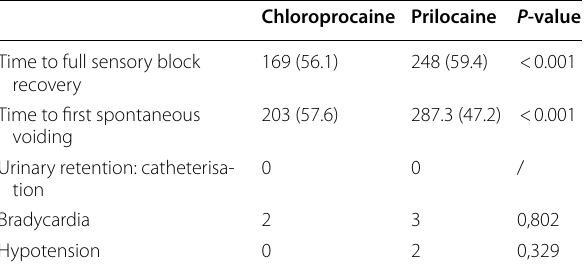
Table 1 Time to full sensory block recovery, time to first spontaneous voiding and side effects. Mean (standard